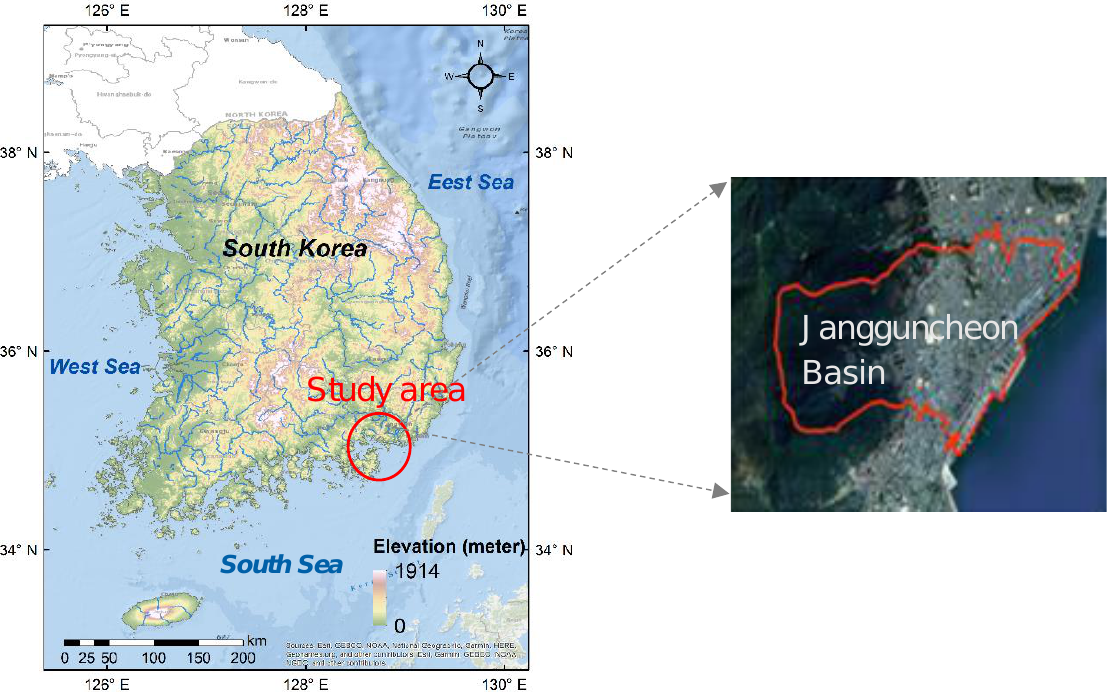
Figure 1. The application area of this study is Jangguncheon Basin in Changwon City, South Korea. The datasets needed to simulate the urban floods using the SWMM model are two types, in terms of hydrological and hydraulic. The hydrological element includes precipita- tion events and topographical information data of the target area, and the hydraulic feature includes sewage pipeline network data. Observed precipitation or designed